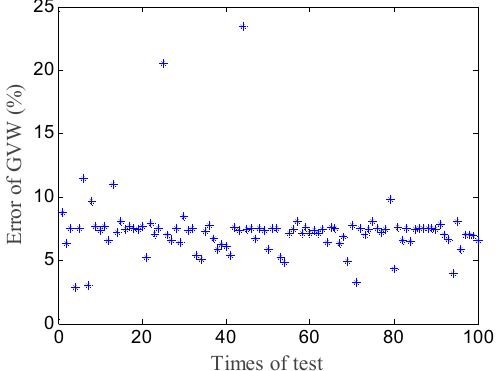
Figure 11. The identified errors of the GVW with 20% noise when d = 28cm.